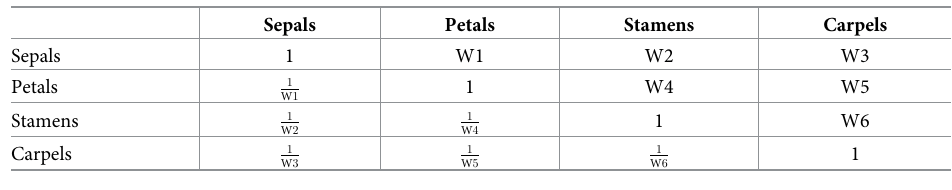
Table 2. W1-W6 value.